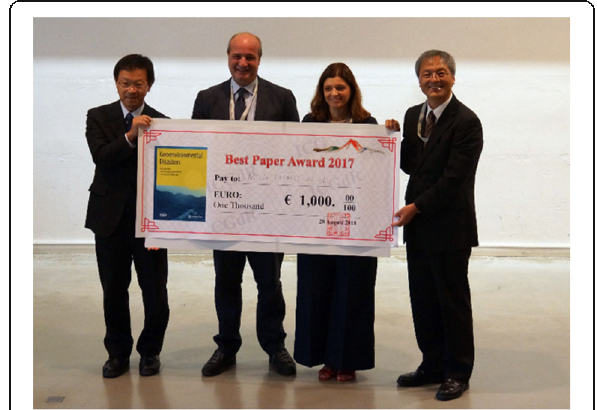
Fig. 4 The winner of the 2017 Best Paper Award of the journal Geo-environmental